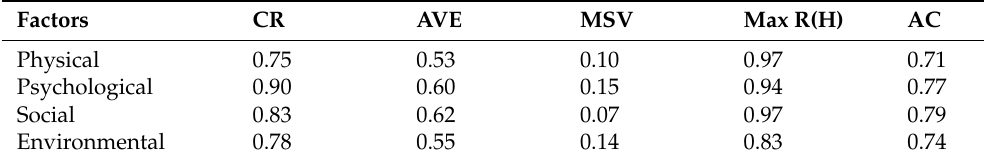
Table 3. Convergent and discriminant